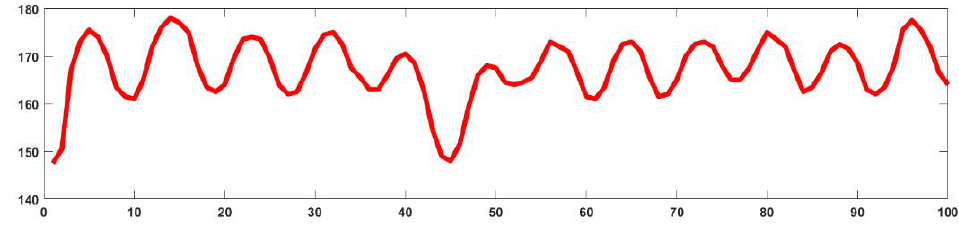
Figure 2. The trajectory of the horizontal